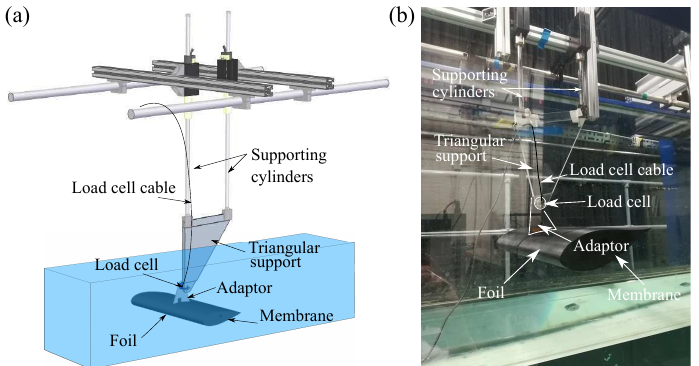
Figure 4. ( a ) Schematic diagram and ( b ) photograph of experimental rig to hold the blade showing the acrylic triangular support, the load cell, the adaptor piece and the